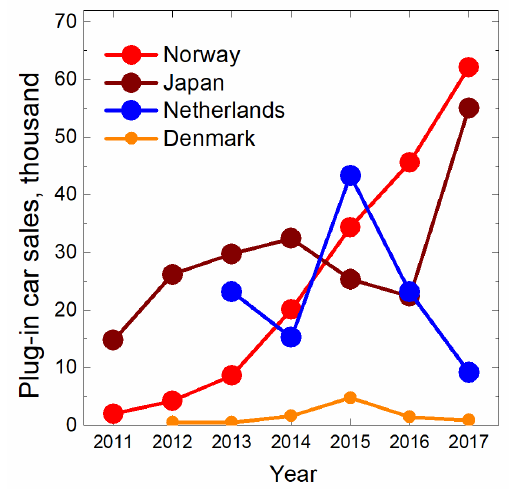
Figure 4. Plug-in car sales decay in the Netherlands and Denmark, compared with the NEV